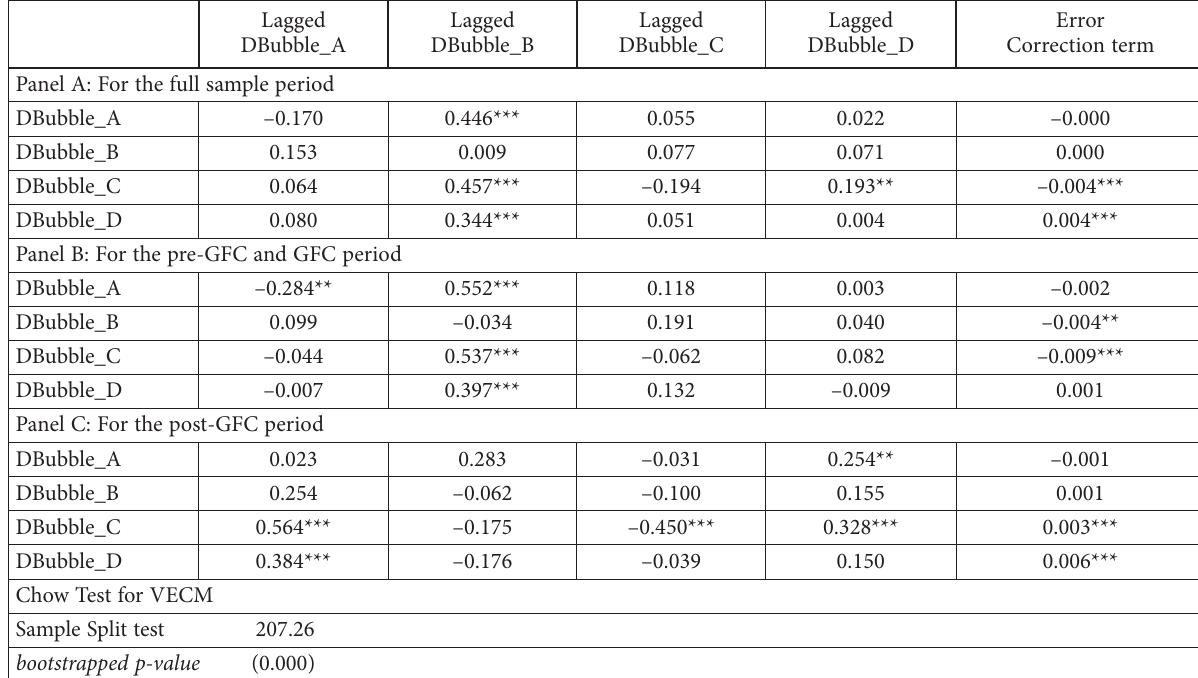
Table 3. The vector error correction model of house price